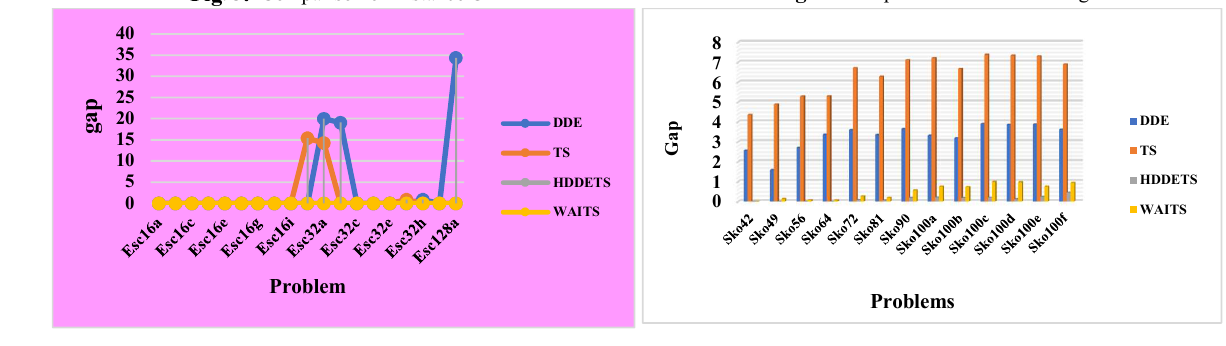
Fig . 3 . Comparison on instance Chr Fig . 4 . Comparison on instance Nug